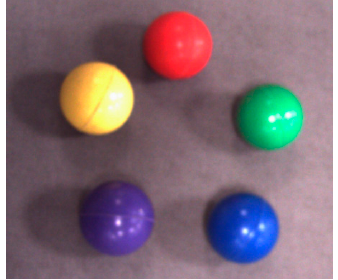
Figure 3. Different coloured objects.